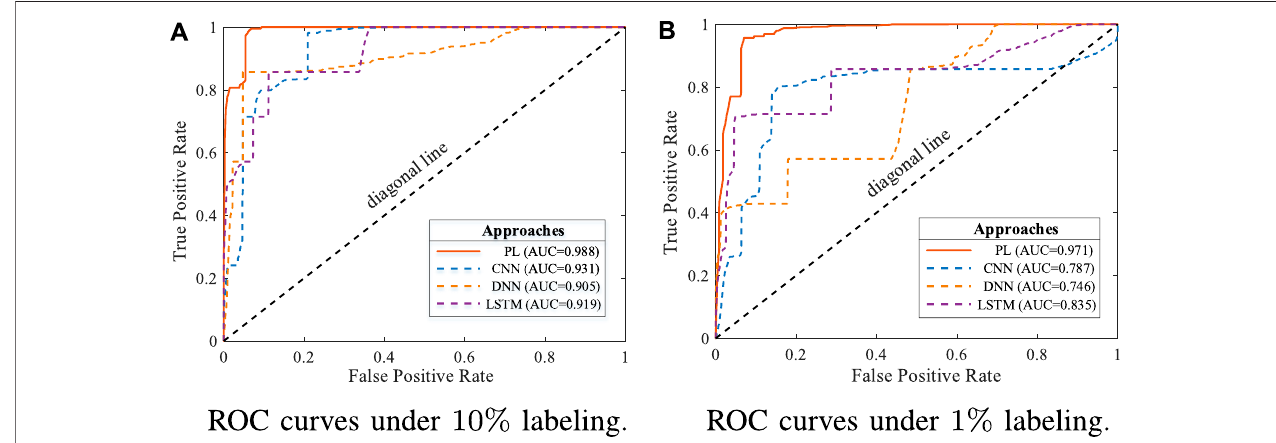
FIGURE 12 | ROC curves and AUCs of approaches under 10 % and 1 % labeling rates. ROC curves are desired to be far away from the diagonal line. (A) ROC curves under 10 % labeling. (B) ROC curves under 1 %